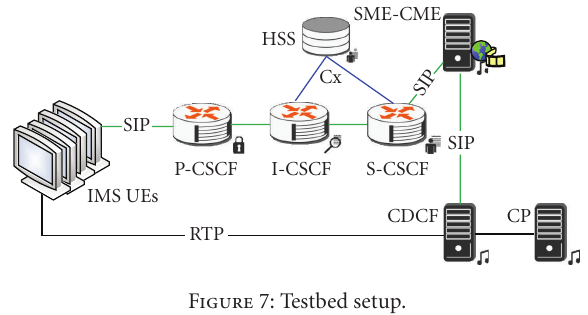
Figure 7: Testbed